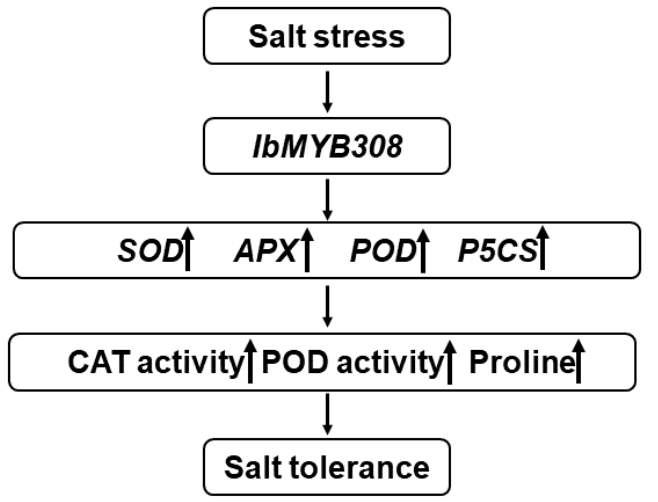
Figure 8. Schematic model of the IbMYB308 regulatory mechanism of the abiotic stress response.